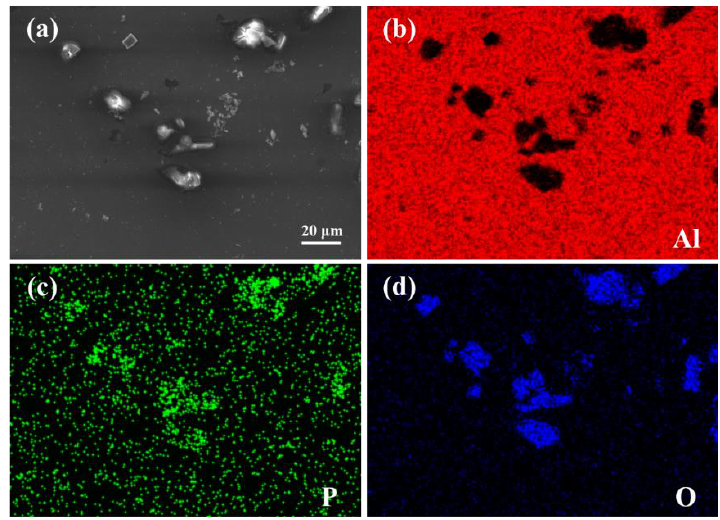
Figure 8. EDS composition of Al-3.5P master alloy ( a ) Morphology of Al-3.5P alloy, ( b ) Al element, ( c ) P element, ( d ) O element.